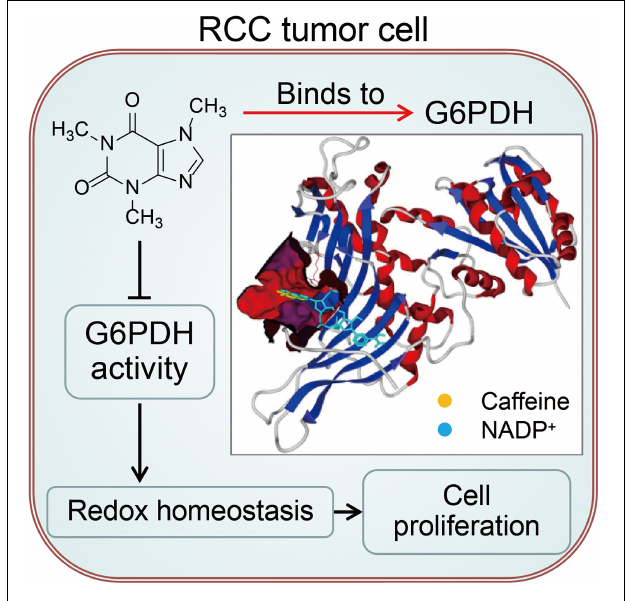
FIGURE 7 | A working model for caffeine targets G6PDH to disrupt redox homeostasis and inhibit RCC cell